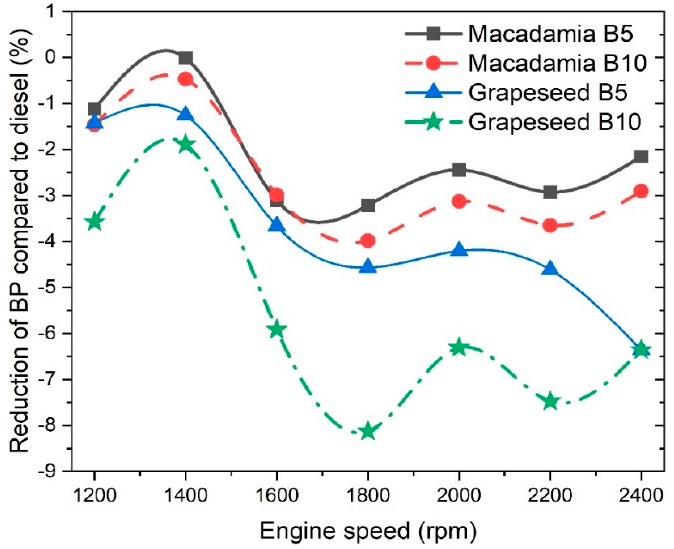
Figure 2. Comparison of brake power (BP) reduction using B5 and B10 biodiesel blends.